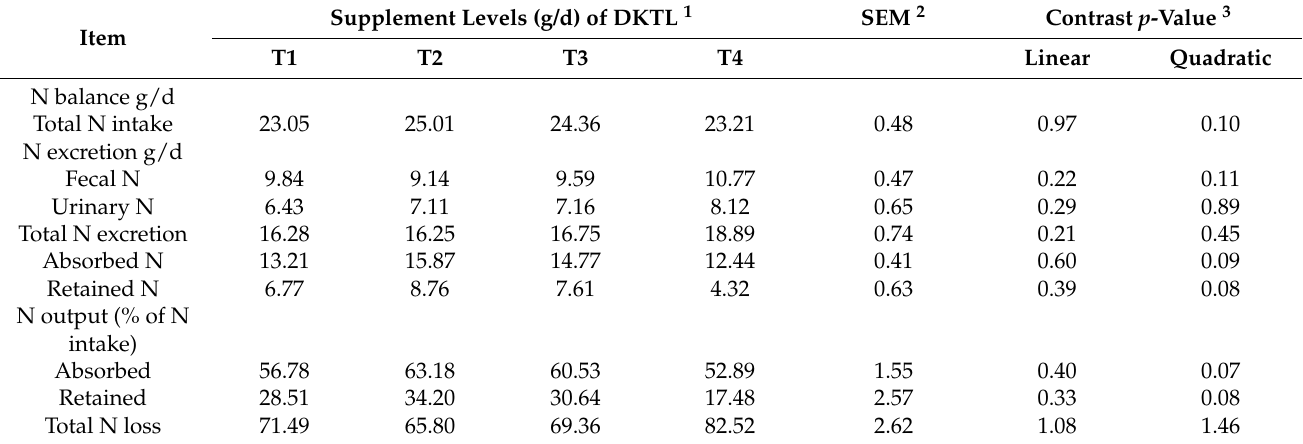
Table 10. Effects of supplement levels (g/d) of dried kratom leaves on N balance in goats.